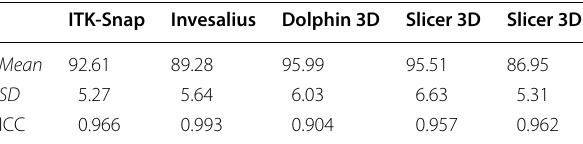
Table 2 Inter-software reliability (Gold Standard vs semi- automatic software) of upper airway